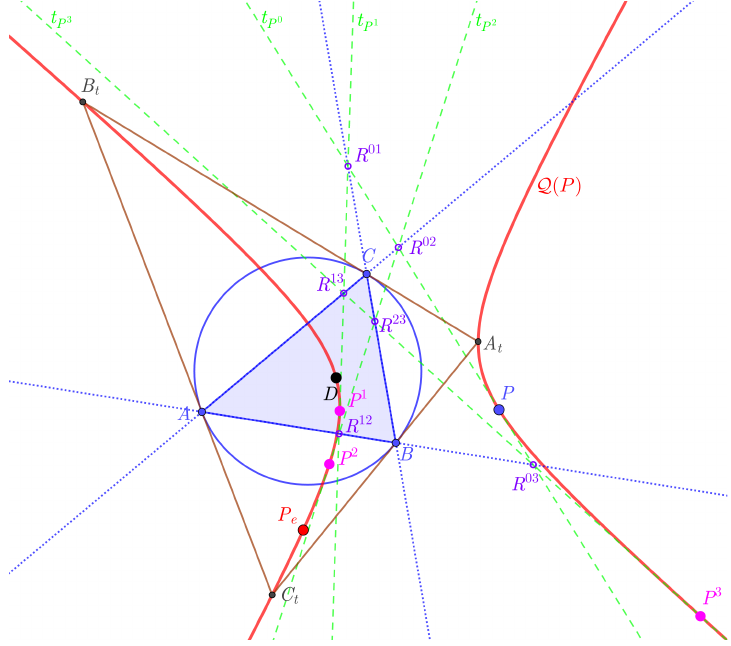
Figure 6. Tangent lines at points P i .